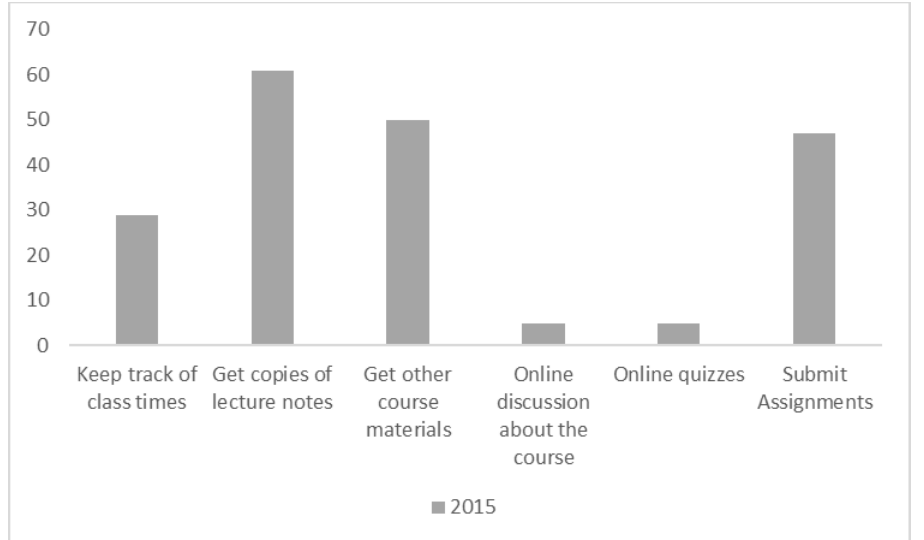
Figure 1. If you use the VLE, why? What are the benefits to you?